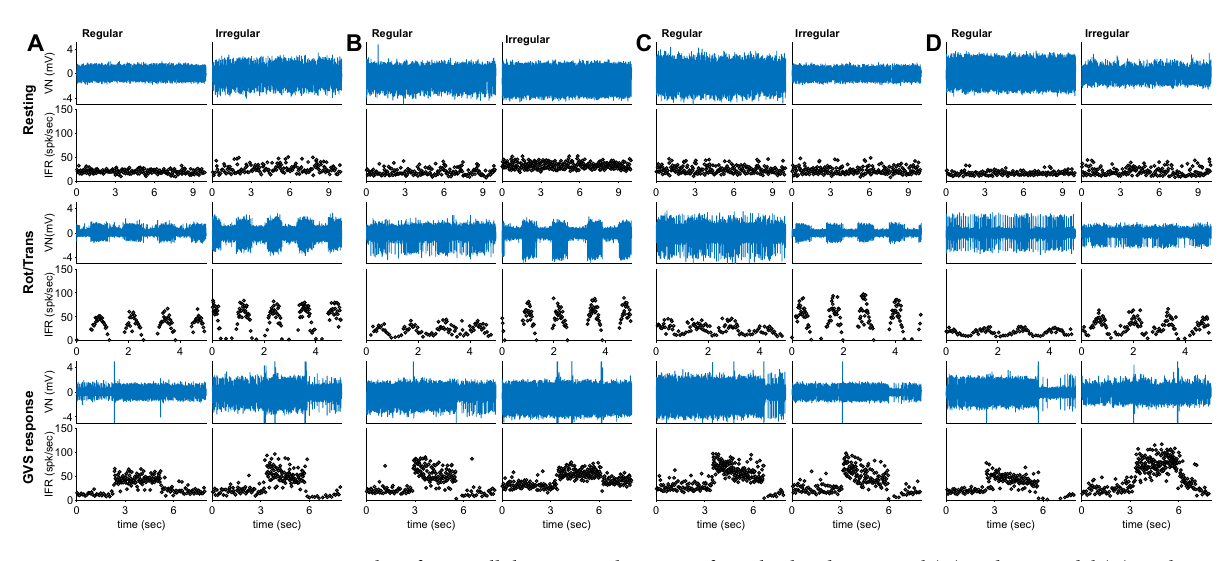
Figure 4. Examples of extracellular neuronal activity of canal-related in normal ( A ) and PD model ( B ), and those of otolith-related neurons in normal ( C ) and PD ( D ). Each group was subdivided based on the discharge regularity. Each row represents a neuronal example, and the neuronal spikes and its relevant instantaneous firing rate (IFR) are shown during resting period, rotation/transmission, and